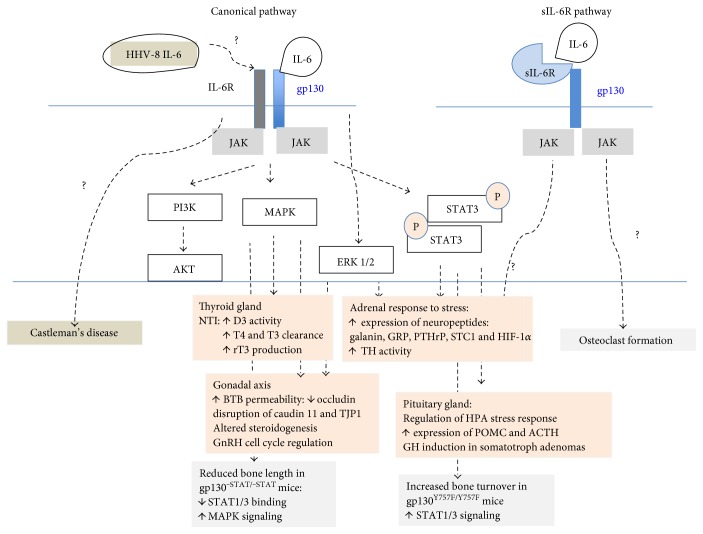
Overview of IL-6/soluble IL-6 receptor signaling at the nexus of endocrine function: illustrative examples. Binding of IL-6 to IL-6R and gp130 receptor complex leads to activation of Janus kinase- (JAK-) dependent pathways including mitogen-activated protein kinase (MAPK), protein kinase B (AKT)-phosphatidylinositol 3-kinase (PI3K), and signal transducer and activator of transcription 3 (STAT3). The IL-6 signaling mediated via a soluble IL-6 receptor (sIL-6R) leads to binding of IL-6/sIL-6R complex to gp130 triggering similar intracellular pathways (adapted from [30, 44, 45, 49]). In the states of NTI (nonthyroidal illness), an increase in rT3 production is a consequence of increased D3-mediated T3 (and T4) clearance through activation of the MAPK pathway [69]. Stress-induced HPA axis activation and GH-induced somatotroph adenoma growth are mediated via the STAT3 pathway [107]. In bovine chromaffin cells exposed to stress, IL-6 leads to activation of ERK 1/2 and STAT3 pathways and consequently to increased activity of tyrosine hydroxylase (TH), a rate-limiting enzyme in catecholamine synthesis, and to upregulation of downstream targets including secreted neuropeptides galanin, PTH-related peptide (PTHrP), G-protein-coupled receptor (GPR), stanniocalcin-1 (STC1), and hypoxia-inducible factor 1α (HIF-1α) [85]. The signaling via gp130 regulates the gonadal axis via activation of ERK and MAPK pathways on multiple levels: cycle regulation and proliferation of GnRH cells, impaired steroidogenesis, and increased permeability of blood-testis barrier (BTB) (through downregulation of occludin and delocalization of claudin 11 and tight junction protein 1 (TJP1)) [77, 115, 116]. Bone phenotype is illustrated through a rodent mutation model, where JAK/STAT and the SHP2/MAPK signaling regulate bone turnover and closure of the growth plate [56]. Soluble IL-6R seems to regulate osteoclast development in vitro; however, its relevance in vivo is unclear [92].